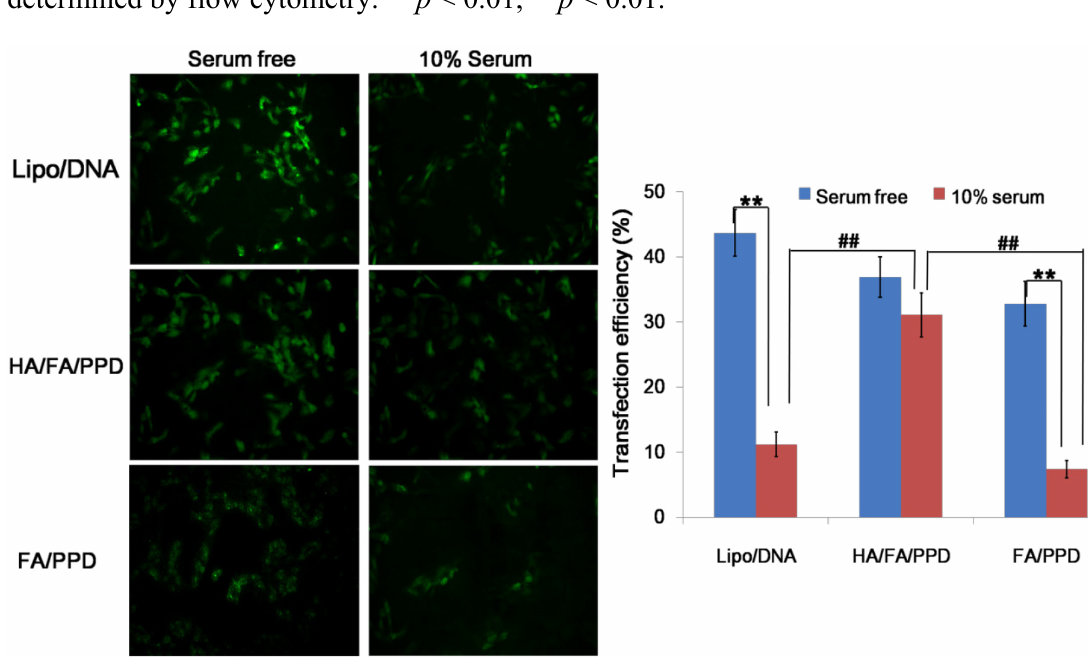
Figure 7. Transfection efficiency of dual targeting HA/FA/PPD on B16 cells ( n = 3). Lipofectamine™ 2000/pDNA and FA/PPD were served as controls. Left panel : Fluorescent micrographs of HA/FA/PPD, FA/PPD and Lipofectamine™ 2000 with or free of 10% serum following 48 h incubation (×20); Right panel : Transfection efficiency quantitatively determined by flow cytometry. ** p < 0.01, ## p <